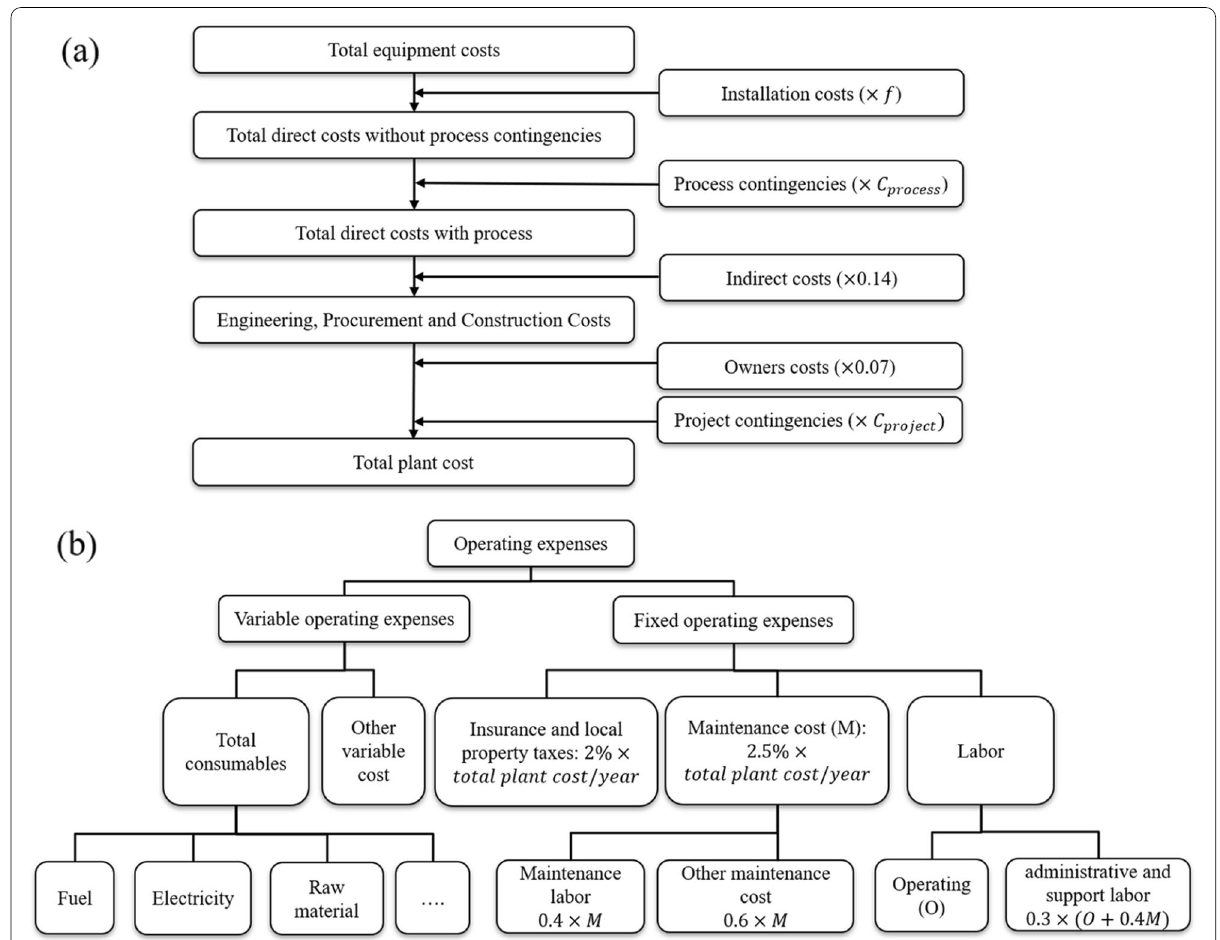
Fig. 3 The economic assessment of ( a ) the total plant costs and ( b ) the operation costs adapted from the Horizon 2020 project “CO2 capture from cement production”